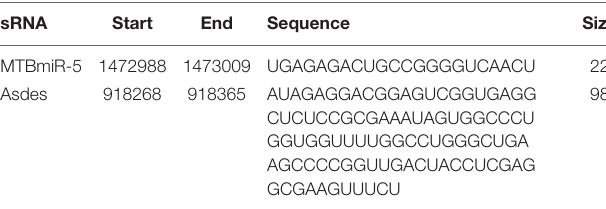
TABLE 1 | M. tuberculosis -encoded ASdes and MTB-miR5. sRNA